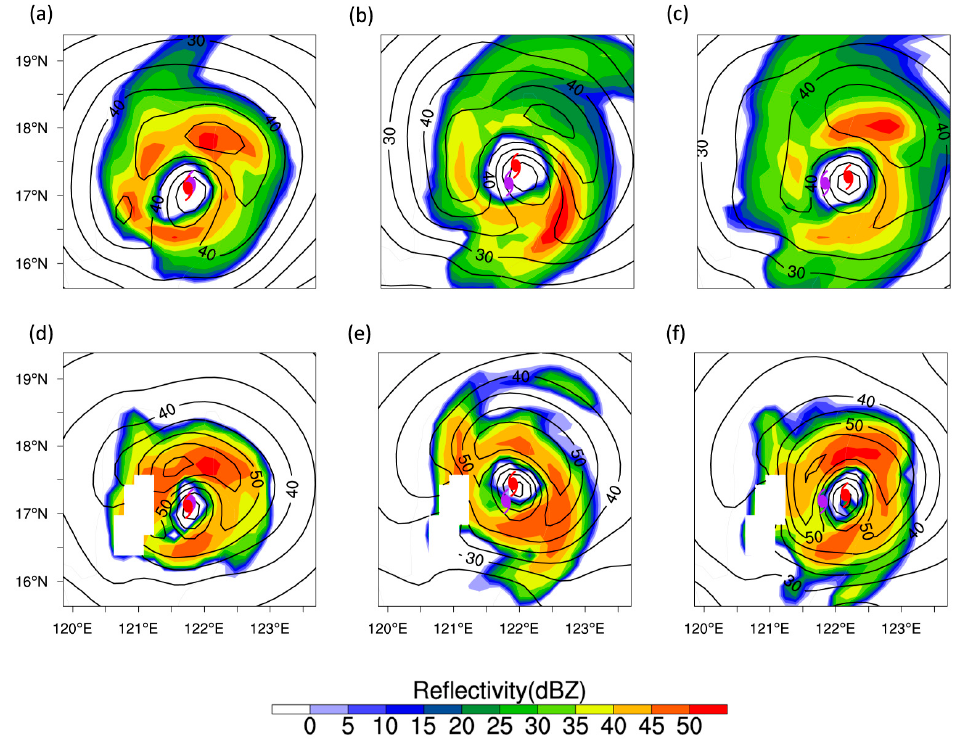
Figure 6. Distribution of radar reflectivity (dashes, units: dBZ) and wind speed (solid lines, units: m s − 1 ) by CTRL ( a , d ), SN1 ( b , e ), SN3 ( c , f ) at 500 hPa ( a – c ) and 850 hPa ( d – f ) at the making-landfall moment (0600 UTC 18); red typhoon symbols represent the simulated typhoon centers while purple typhoon symbols represent the observed typhoon centers.